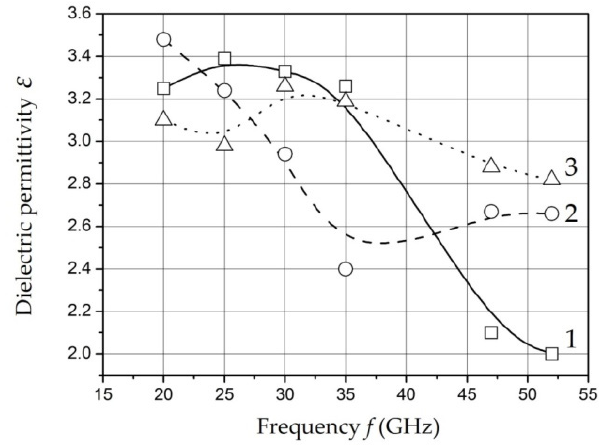
Figure 14. The dependence of the dielectric permittivity of the samples Fe -01 (1), Fe -02 (2), and Fe -03 (3) on the operating frequency. Adapted from [129] with permission.